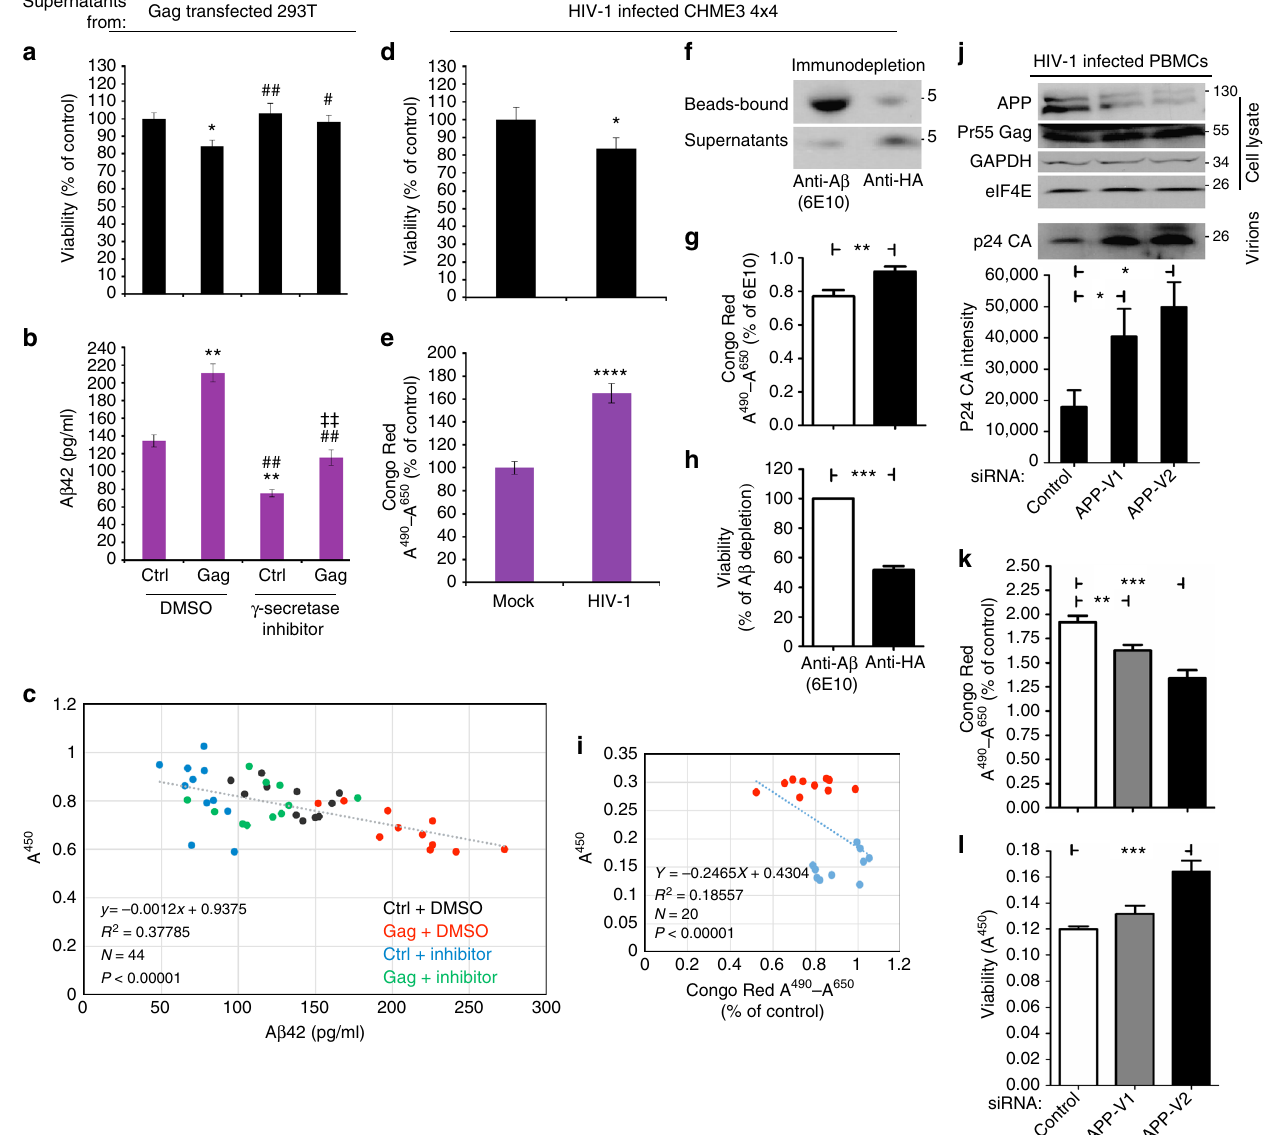
Fig. 6 HIV-1 Gag-induced A β 42 production causes neurodegeneration. a Cortical neurons treated with supernatants from 293T cells co-transfected with APP-Flag along with either pGAPDH-HA (Ctrl) or HIV-1 Gag (Gag) reveals neurotoxicity caused by Gag expression. * P < 0.05 vs. Ctrl; # P < 0.05, ## P < 0.01 vs. gag (one-way ANOVA; n = 11; F 40,3 = 5.665; P < 0.05). b ELISA analysis of A β 42 levels in denatured supernatants from a. ** P < 0.01 vs. Ctrl, ## P < 0.01 vs. gag, ‡‡ P < 0.01 vs. Ctrl + inhibitor (one-way ANOVA; n = 11; F 40,3 = 53.340; P < 0.001). Bars represent SEM. c Regression plot showing the correlation between cell viability and A β 42 levels from a-b (F 42,1 = 25.508; P < 0.00001; R 2 = 0.378). d Cortical neurons treated with supernatants from mock or WT HIV-1-infected CHME3 4 × 4 cells reveals neurotoxicity caused by HIV-1. * P < 0.05 vs. mock; ( n = 11; t 20 = 2.49; P < 0.05). e Congo Red staining of amyloid levels in supernatants from d . **** P < 0.0001 vs. mock ( n = 11; t 20 = -9.37; P < 0.0001). Bars represent SEM. f Bead-bound and supernatant levels of A β in 6E10 or anti-HA antibody-treated samples from WT HIV-1-infected CHME3 4 × 4. g Congo Red staining of amyloid levels in supernatants from f . ( n = 10, ** P < 0.01). h Cortical neurons treated with supernatants from f . ( n = 10, *** P < 0.001). i Regression plot showing the correlation between cell viability and A β levels from samples in f – h (F 17,1 = 3.874; P < 0.00001; R 2 = 0.186). j – l APP depletion in PBMCs infected with WT HIV-1 causes an increase in p24 CA j , a decrease in A β levels determined by Congo Red staining ( k ) and a corresponding increase in viability of cortical neurons treated with supernatants from j , l . The data in j (lower panel), k , l represent mean +/ − SEM. k Congo Red staining of amyloid levels in supernatants from j . ** P < 0.01 vs. Ctrl, *** P < 0.001 vs. Ctrl, (one-way ANOVA; n = 10, P < 0.001). l Cortical neurons treated with clari fi ed supernatants from PBMCs treated as in j , k reveals APP depletion reduces neurotoxicity caused by infection and its inverse correlation with amyloid levels. *** P < 0.001 vs. Ctrl (one-way ANOVA; n = 10, P < 0.001). Molecular weight markers (in kDa) are shown to the right of